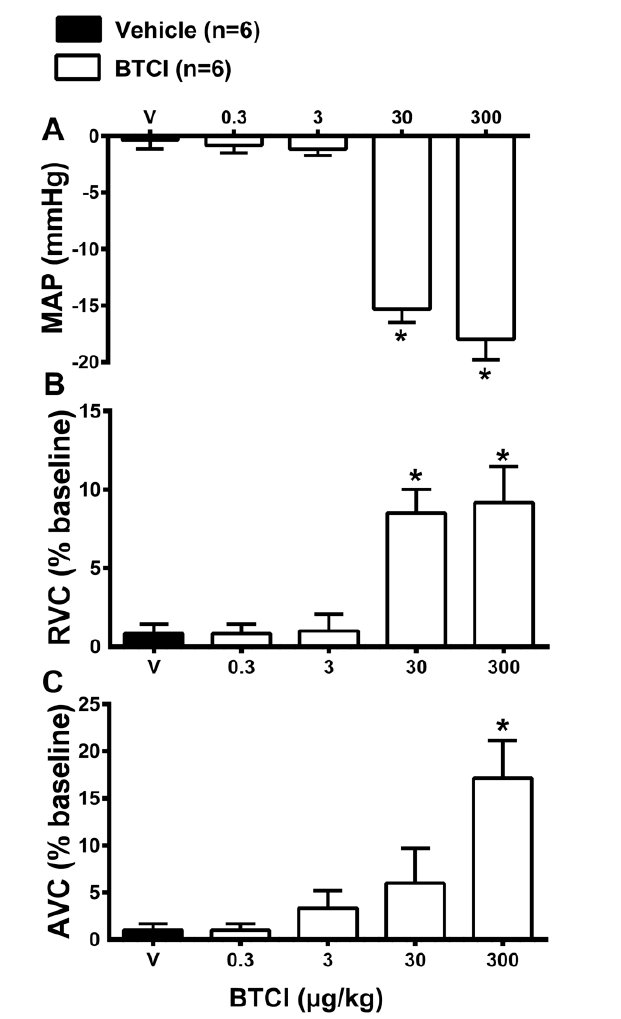
Figure 9. BTCI and hemodynamic effects. Cardiovascular responses induced by intravenous administration of BTCI (0.3, 3, 30 and 300 µg·kg − 1 of b.wt, in 0.1 mL) or Vehicle